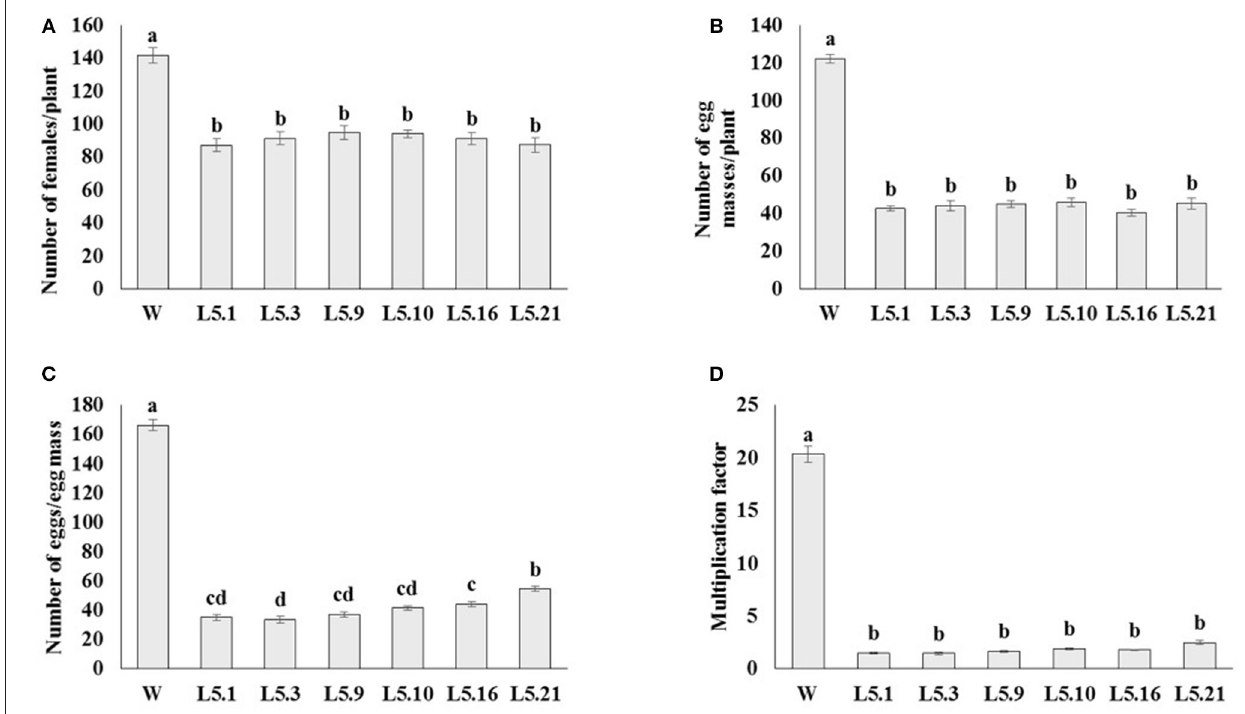
FIGURE 8 | Effect of host generated RNAi of Lemmi-5 on (A) relative number of females/plant, (B) egg masses/plant, (C) eggs/egg mass, and (D) multiplication factor in transgenic tomato events (L5.1, L5.3, L5.9, L5.10, L5.16, and L5.21) and wildtype (W) tomato plants after 35 days of inoculation. Each bar represents mean ± standard error of six different plants of each event. Bars with different letters indicate statistically significant difference between the treatments ( P < 0.05) according to Tukey’s test (Tukey’s HSD).